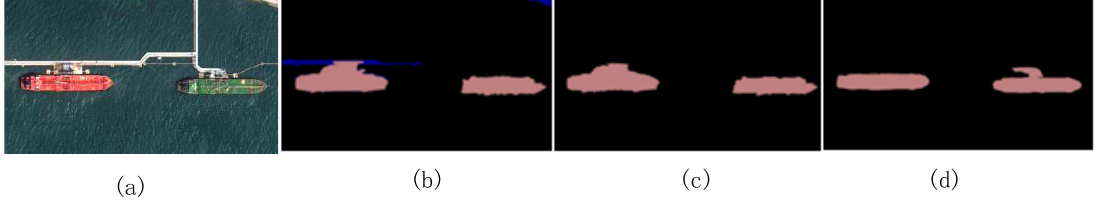
Figure 7. Semantic segmentation of ships within a port . ( a ) Original ( b )CRF-RNN ( c ) DeepLab ( d ) Proposed model (a) (b) (c) (d) Figure 8. Semantic segmentation of ships under thin clouds. ( a ) Original ( b )CRF-RNN ( c ) DeepLab ( d ) Proposed model (a) (b) (c) (d) Figure 9. Semantic segmentation of ships with an island ( a ) Original ( b )CRF-RNN ( c ) DeepLab ( d ) Proposed model 4.2. Quantitative Result We then quantitatively analyzed the model. Qualitative analysis is not enough, since detailed and specific conclusions cannot be generated. Therefore, quantitative methods can provide more detailed and specific data support for the argumentation process. These methods include precision, recall, F-measure analysis, receiver operating characteristic (ROC) and area under the curve (AUC) analysis, s confusion matrix, and runtime analysis. 4.2.1. Precision, Recall, and F-Measure Analysis We used precision, recall, and F-measure [24] as evaluation criteria to verify the advantages of the model. Precision is the ratio of the number of positive samples predicted correctly to the